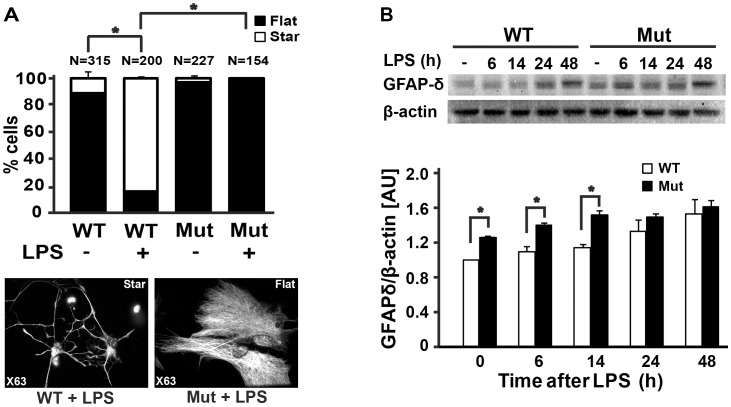
Eif2b5R132H/R132H primary astrocytes exhibit abnormal morphology and overexpress GFAP-δ.(A) Primary astrocytes isolated from Eif2b5R132H/R132H (Mut) and wild-type (WT) mice were incubated with 2 µg/ml LPS for 48 h followed by immunostaining for GFAP. Typical “flat” and “star” morphology is shown (photographed with ×63 objective). All cells within random fields (photographed with ×10 objective) were counted and assigned “star” or “flat” morphology (N = number of cells). Bars represent percent of “star” (white) or “flat” (black) morphology (*p<0.001). (B) WT and Mut primary astrocytes were treated with 2 µg/ml LPS for the indicated times, followed by immunoblot analysis of GFAP-δ and β-actin. GFAP-δ/β-actin levels were normalised to untreated WT cells. Bars represent the average of GFAP-δ/β-actin levels of 3 independent experiments ± SEM. (WT, white; Mut, black; *, p<0.005).